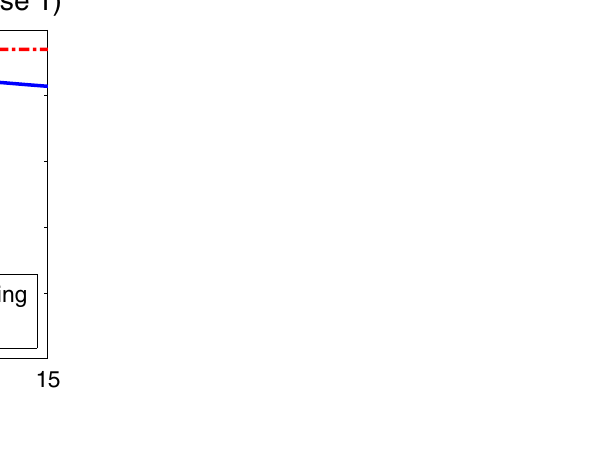
Figure 8. Correct decision rate in case